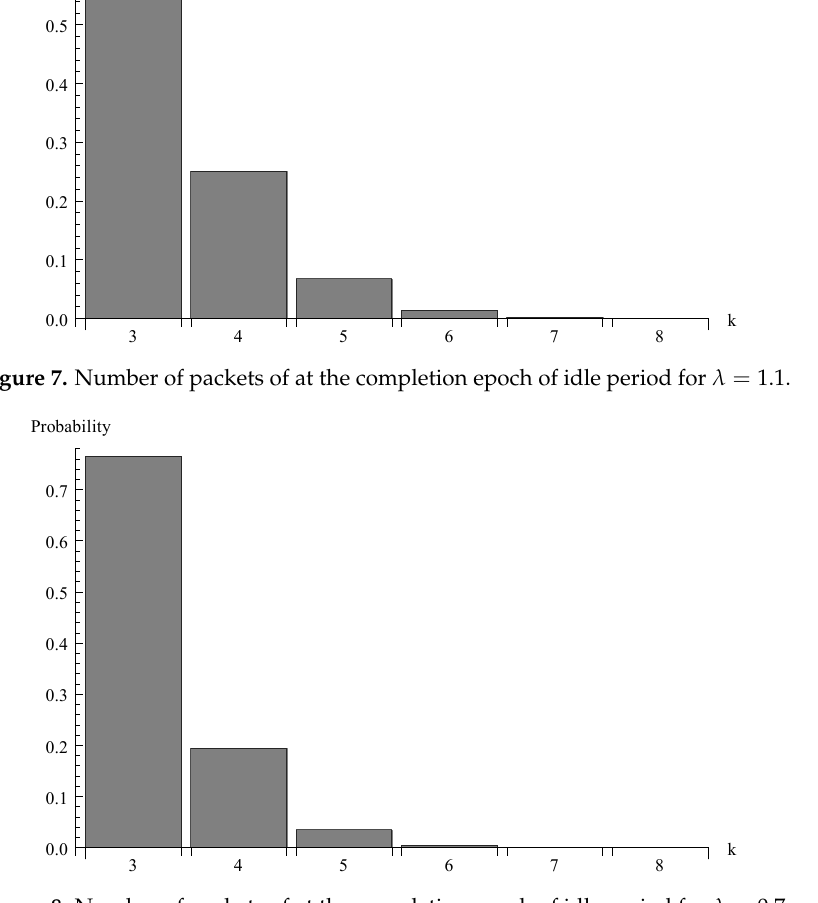
Figure 8. Number of packets of at the completion epoch of idle period for λ = 0.7.